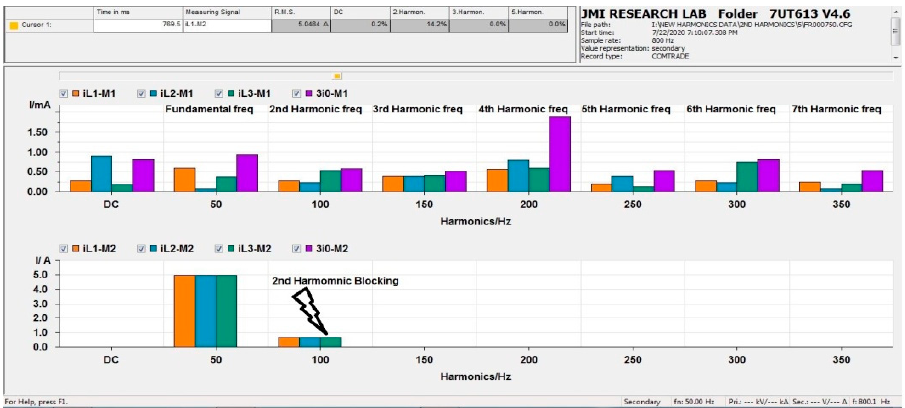
Figure 20. 2nd HB at 5000 mA Rated current & 15% of Inrush current condition.